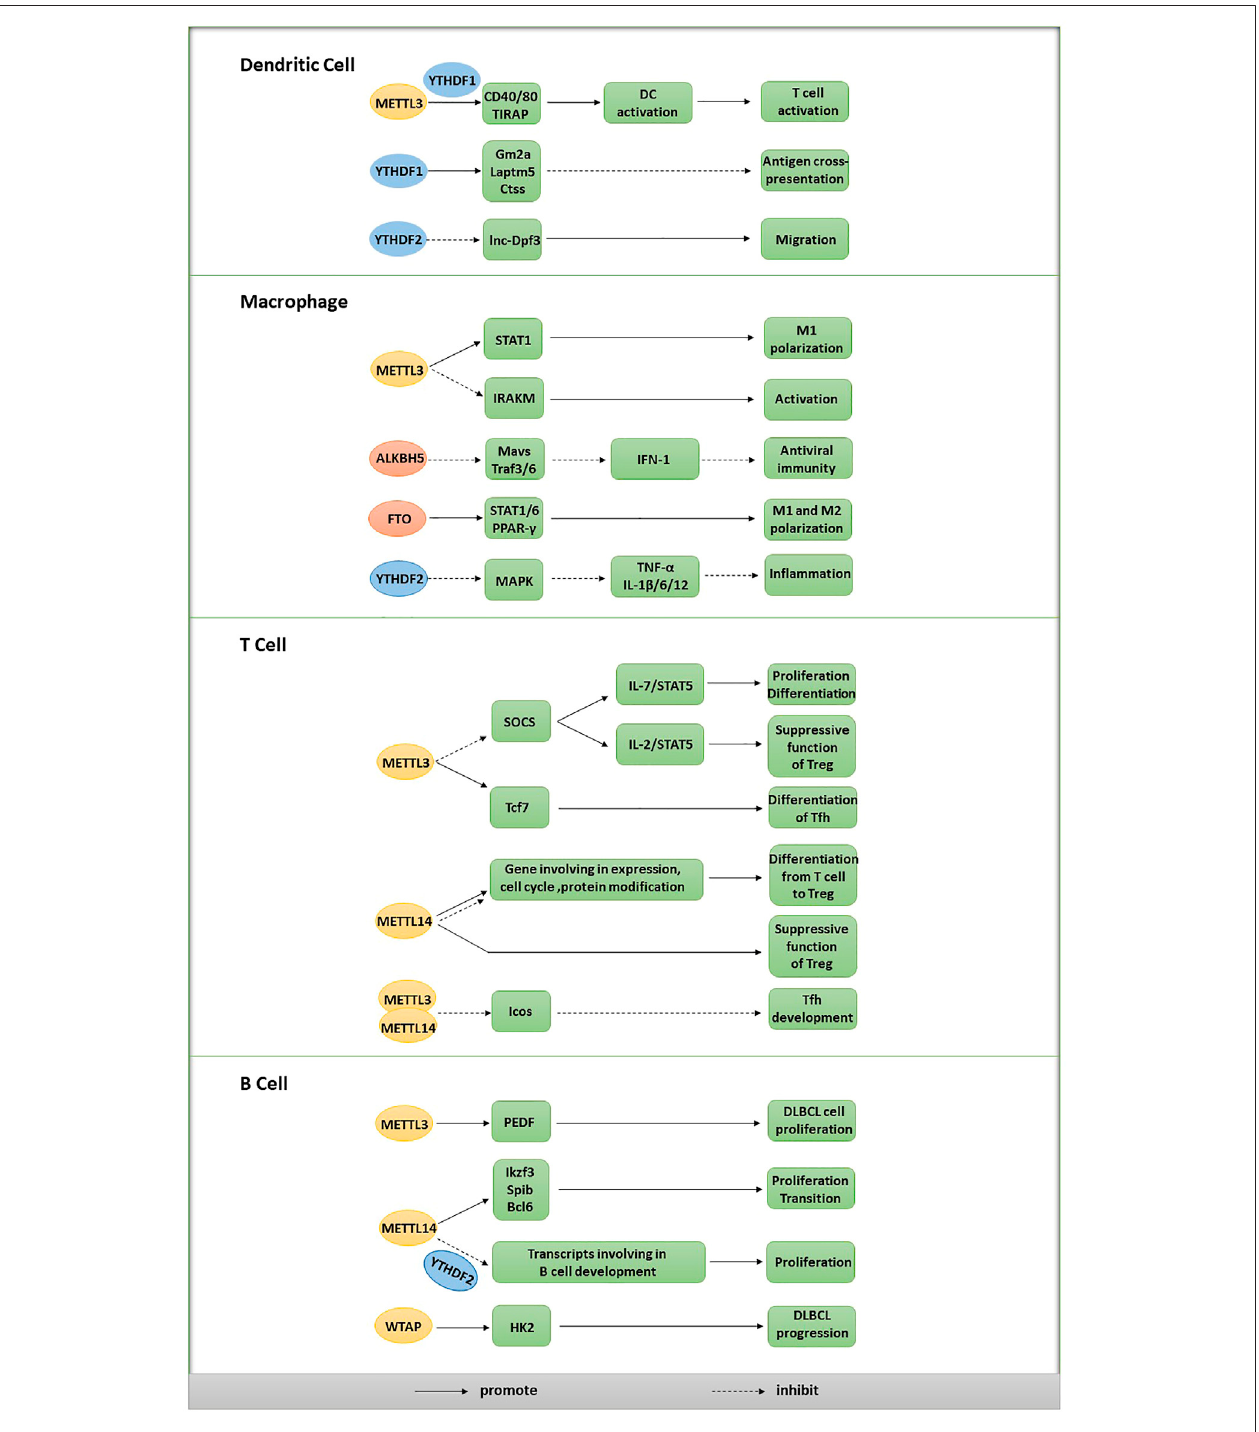
FIGURE 2 | Effects of m6A on different types of immune